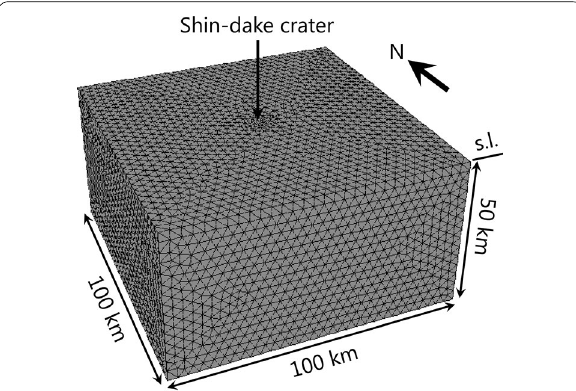
Fig. 5 FE domain set in the present study